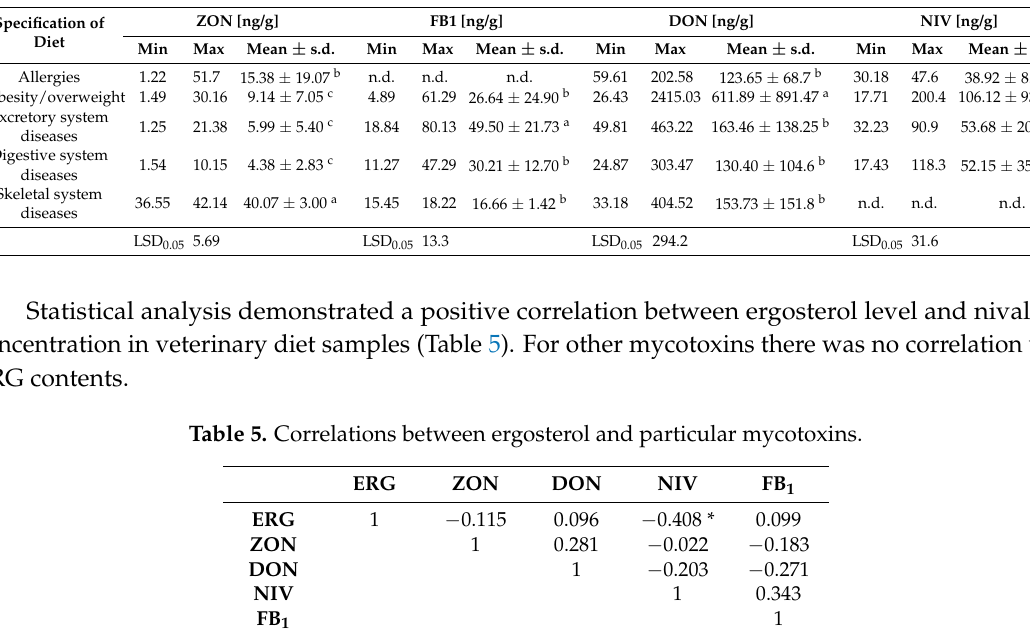
Table 4. Minimum, maximum, and average values of ZON and FB 1 , and DON and NIV in veterinary diets. Diets were grouped based on the diseases, consecutive upper superscript letters mark groups which differ significantly.